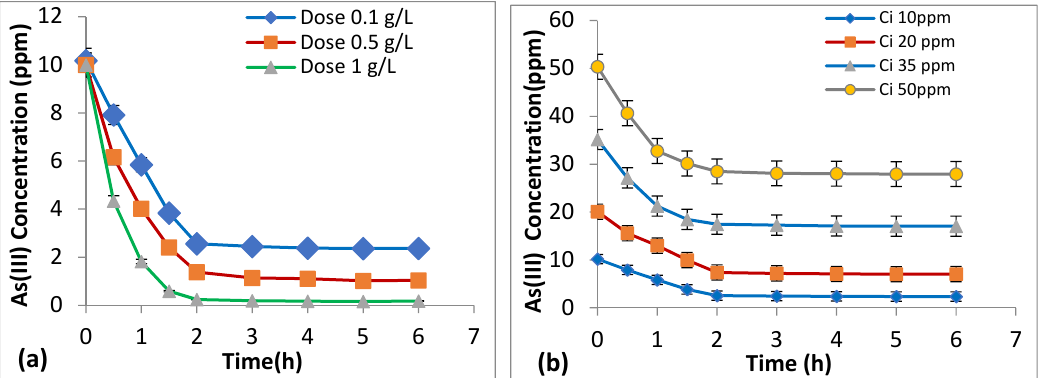
Figure 6. Adsorption kinetics for decrease in As (III) concentration with time at pH 6 and room temperature: ( a ) adsorption isotherm for different adsorbent dosages (0.1–1.0) g/L and initial As (III) conc. 10 mg/L w.r.t. time. ( b ) Adsorption isotherm at varying conc. (10–50) mg/L and adsorbent dose of 0.1 g/L.